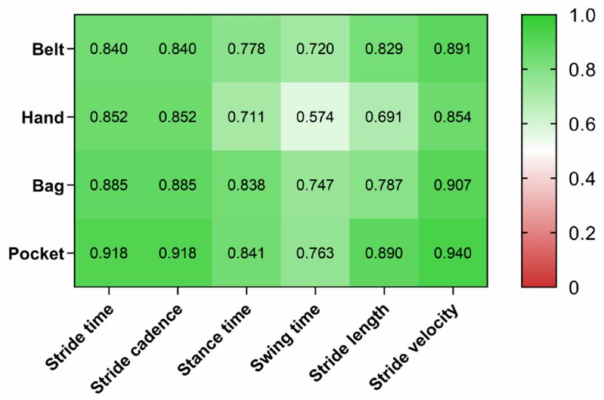
Figure 4. Spearman correlation coefficient ( ρ ) with Pants location for all other locations and for all gait metrics ( p < 0 .001 for all